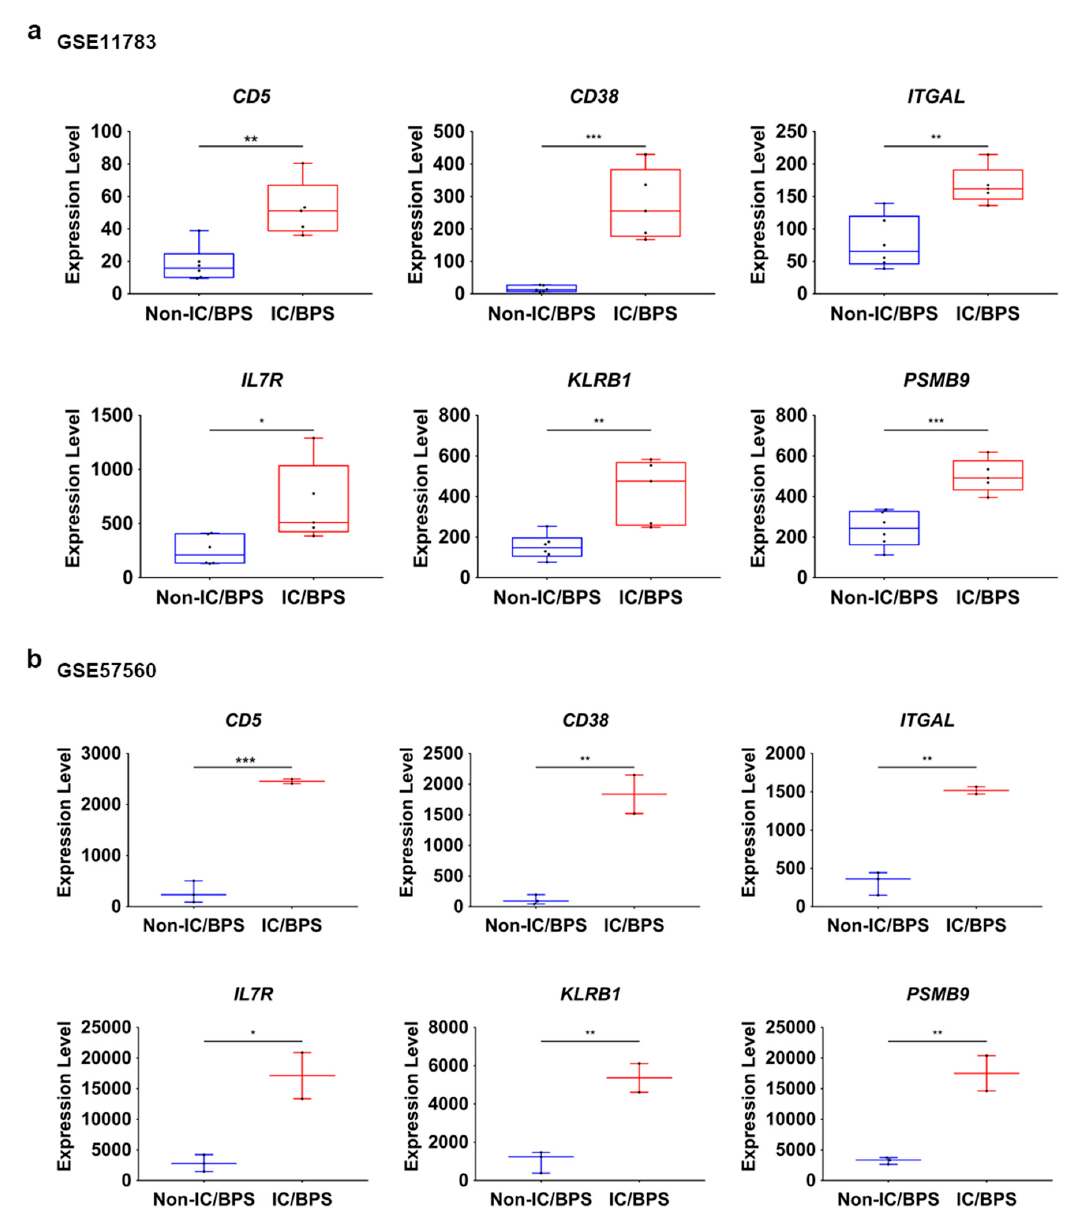
Figure 7. Expression of hub genes in IC / BPS datasets. Box plot data were acquired from GEO datasets, which included ( a ) GSE11783 and ( b ) GSE57560. Comparison of expression of 6 hub genes between IC with Hunner lesiosn (HL) and control. These box plots were made, and statistical analysis performed, using GraphPad prism. The p -value was analyzed using a two-tailed unpaired t -test. Asterisk symbols indicate * p < 0.05, ** p < 0.01, and *** p < 0.001.